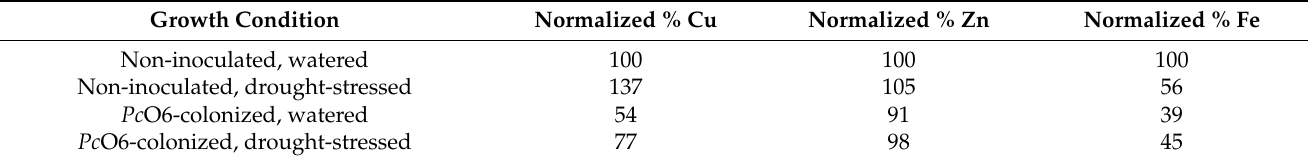
Table 1. Effect of changes in metabolites in rhizosphere solutions on the concentrations of soluble Cu, Fe, or Zn. The predictions are based on the concentrations of the metabolites detected in the rhizosphere solutions obtained from plants grown with and without drought and with and without inoculation by Pc O6. Dissolutions are normalized by setting the value of the watered, non-inoculated treatment to 100%. The molar levels of the three soluble metals in the watered, non-inoculated treatment (defined as 100%) are Cu: 5.29 × 10 − 6 M (336 µ g/L), Zn: 8.13 × 10 − 4 M (53.2 mg/L), and Fe: 1.4 × 10 − 4 M (7.8